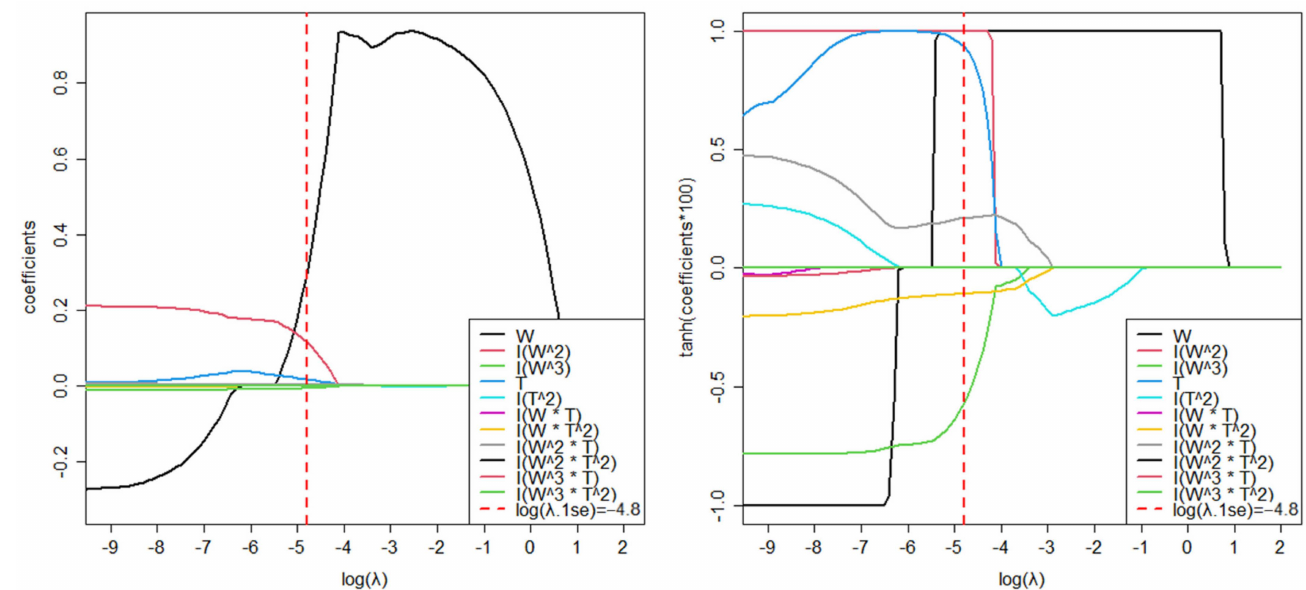
Figure A2. Relationship between the regularization parameter λ and the coefficients in LASSO regression (i.e., cases with no mean value correction for the underlying indexes). The graph on the right transforms the scale of the left graph using the hyperbolic tangent function ( tanh ( 100 x ) ) for ease of